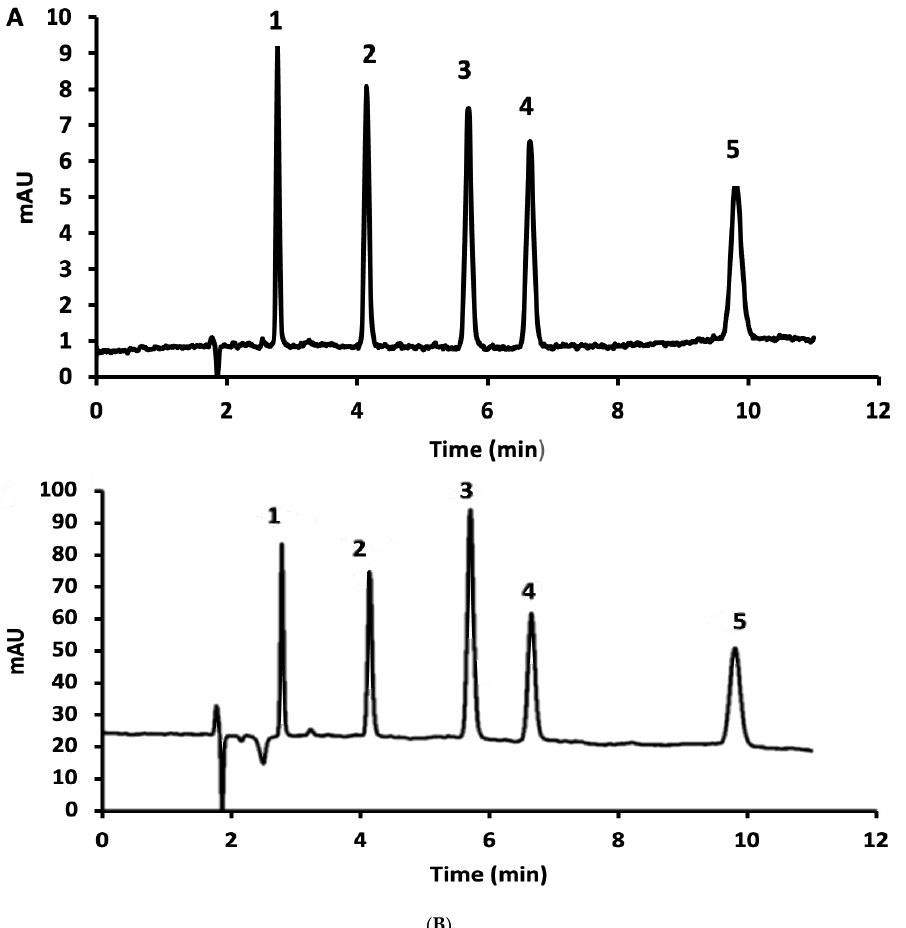
Figure 2. Chromatograms using 96% hexanes and 4% DMC. Peak assignments are as follows: 1, dioctyl phthalate; 2, dibutyl phthalate; 3, benzyl butyl phthalate; 4, diethyl phthalate; and 5, dimethyl phthalate. UV detection: ( A ) 254 nm, ( B ) 215 nm.